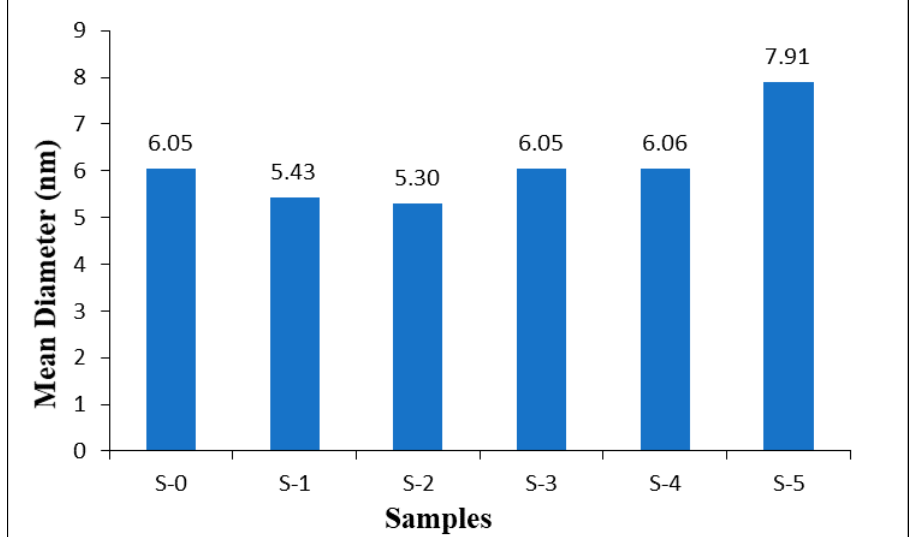
Figure 5. The mean diameters of the raw and treated shale samples.